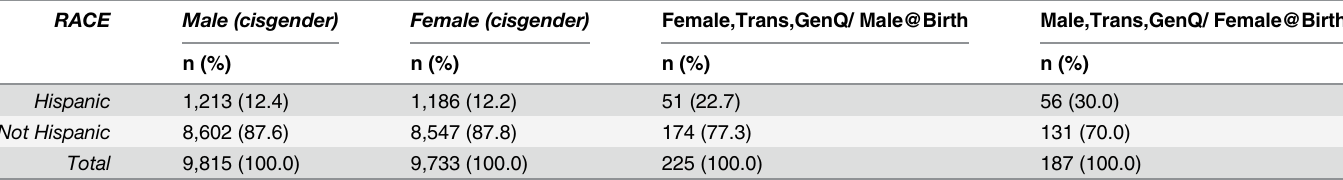
Table 8. Ethnicity and Transgender Status in a Google Android Panel Sample.